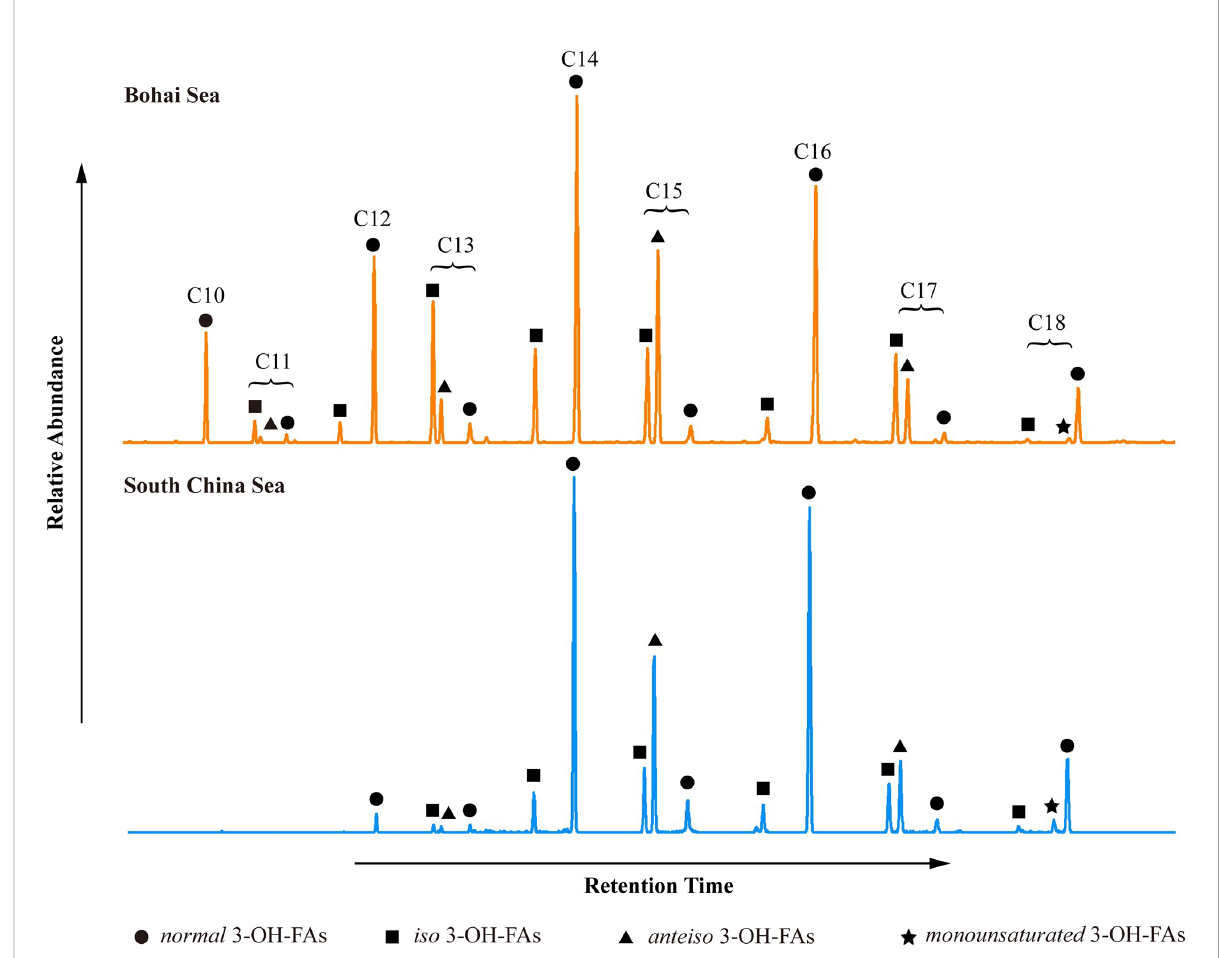
FIGURE 2 Examples showing typical distributions of 3-OH-FAs from the BS and SCS. The abundance of C 10 and C 11 3-OH-FAs are below the detection limit and C 13 3-OH-FAs are low in samples from the